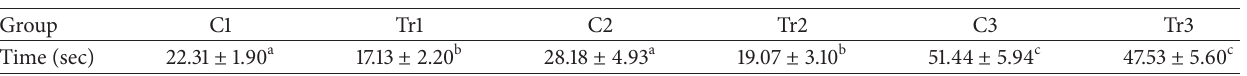
Table 3: Average time spent by control (C1, C2, and C3) and treated (Tr1, Tr2, and Tr3) groups in target quadrant. Data are shown as mean values ± SEM. Values not sharing the same letter are significantly different; 𝑃 < 0.01 .